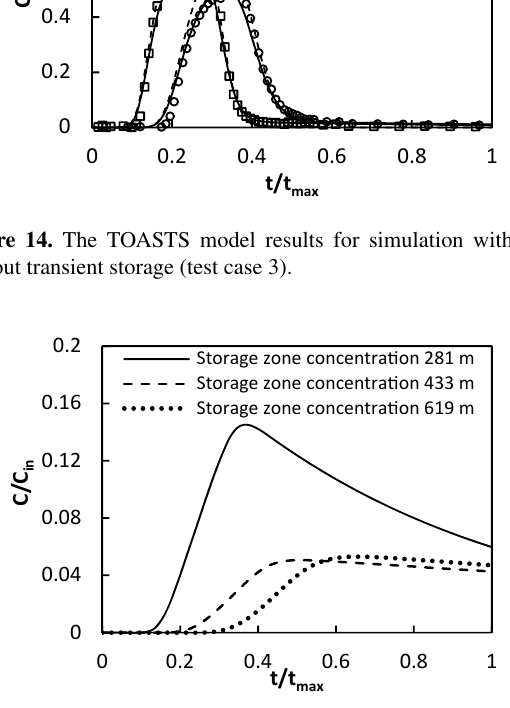
Figure 15. Observed and simulated storage zone concentrations computed by the TOASTS model (test case